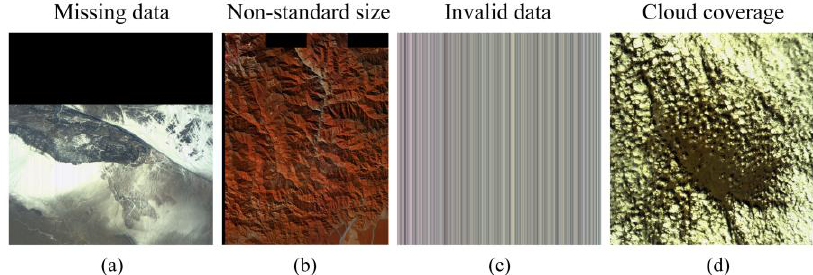
Figure 15. The main target of data quality assessment. ( a ) the GF-5 images with missing data. ( b ) the GF-5 images with non-standard image size. ( c ) the GF-5 images with invalid data. ( d ) the GF-5 images with cloud coverage.